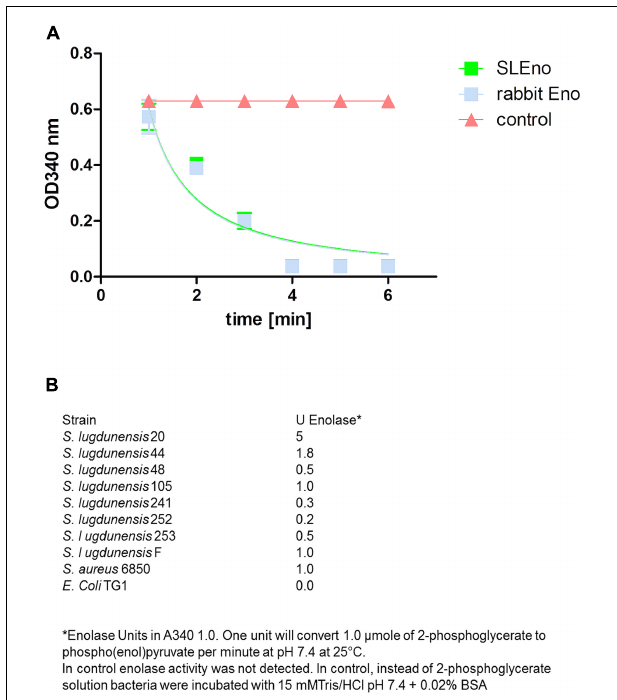
FIGURE 5 | Enzymatic activity of enolases of S. lugdunensis , rabbit, and further different species. (A) The enzymatic activity of purified SlEno and rabbit enolase was measured over time using a coupled enzyme assay based on the conversion of 2-phosphoglycerate to phosphoenolpyruvate (PEP) followed by the conversion of PEP to pyruvate and last lactate by pyruvate kinase and lactate dehydrogenase. The resulting conversion of NADH + H to NAD + was measured. The amount of NADH oxidized in the above reaction is stoichiometric to the amount of 2-phosphoglycerate. As a control, enolase was omitted. (B) Glycolytic activities of enolases were measured in intact, but formaldehyde-fixed cells of different S. lugdunensis strains, S. aureus , and E. coli TG1. Shown are the enolase units.